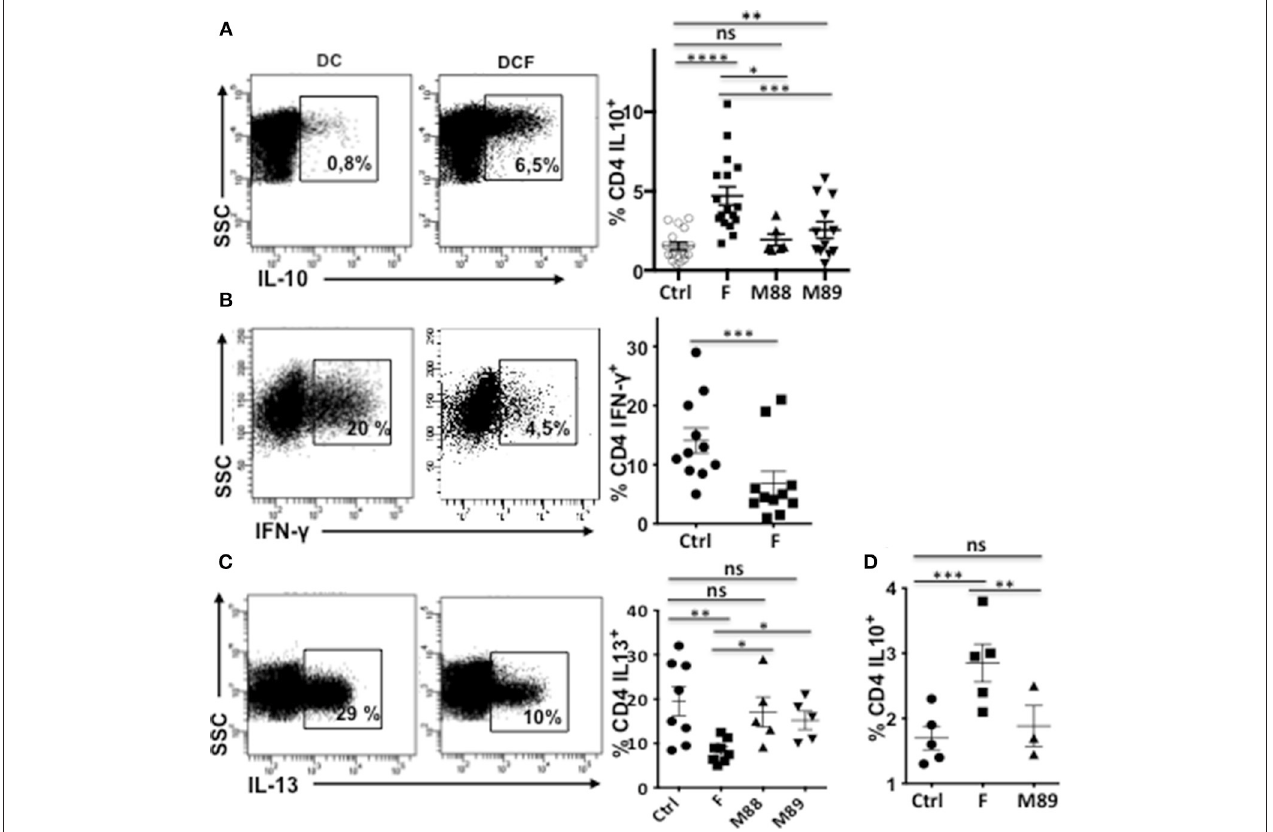
FIGURE 1 | Exposure to F. prausnitzii (F) promotes DC ability to prime IL-10-secreting T cells. VPD-stained naïve CD4 + T cells were stimulated by LPS-stimulated DC, pre-exposed or not to indicated bacteria at day 0 [ (A) n = 6–18, (B) n = 11, (C) n = 5–7] or from day 4 to 6 of their differentiation [ (D) n = 5], and were re-stimulated by CD3/CD28 beads. Representative examples and mean percentages ± sem of CD4T cells expressing indicated cytokines. Paired t -test: * p < 0.05, ** p < 0.005, *** p < 0.0005, and **** p <